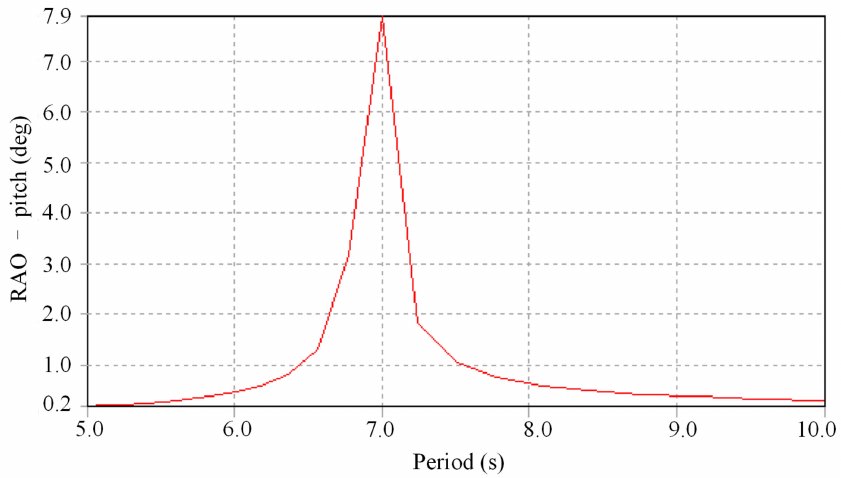
Figure 2. RAO for the float under waves.